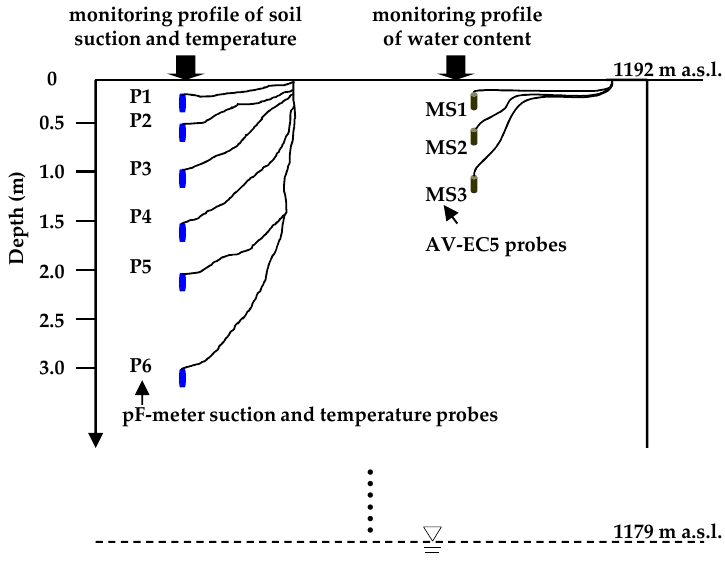
Figure 2. Schematic diagram of the instruments used for soil water